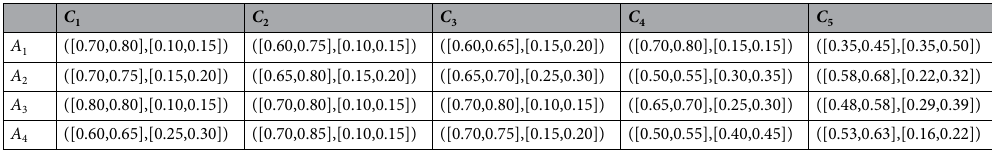
Table 1. Interval-valued intuitionistic fuzzy matrix given by decision-maker E 1 .